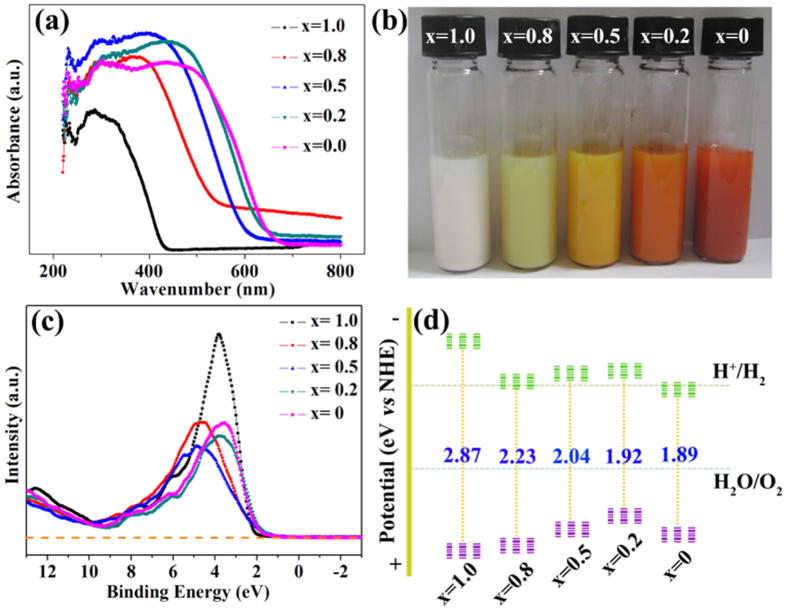
(a) UV- vis absorption spectra, (b) corresponding colors, (c) VB spectra, and (d) relative CB and VB position of BiOBrxI1−x.